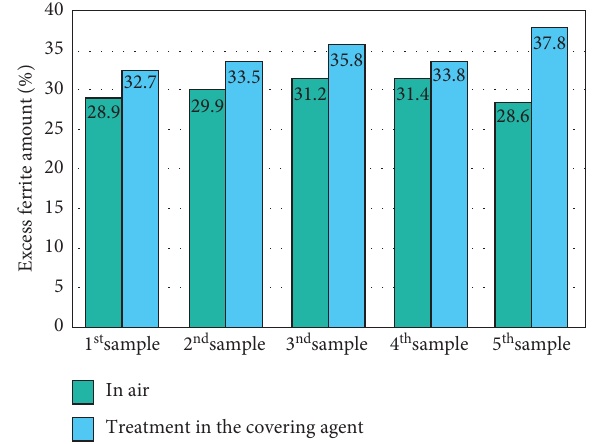
Figure 23: The distribution of the excess ferrite amount in the deposited steel S 45 samples after cooling in air and cooling in the covering